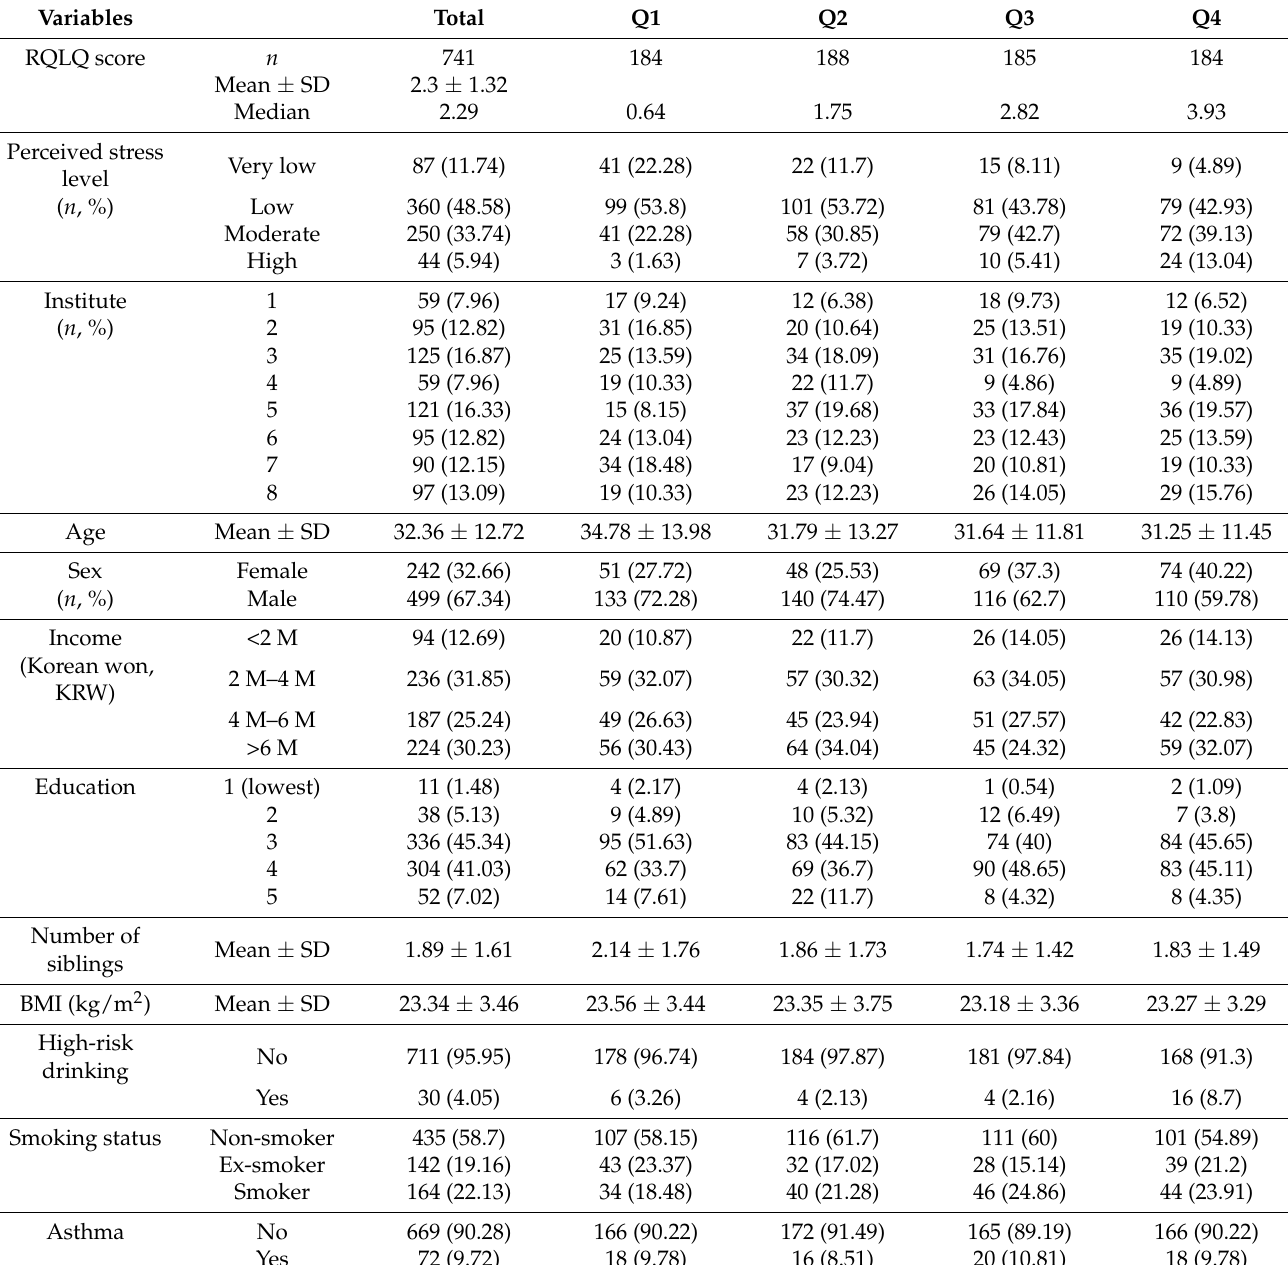
Table 1. General characteristics of participants according to total RQLQ score and